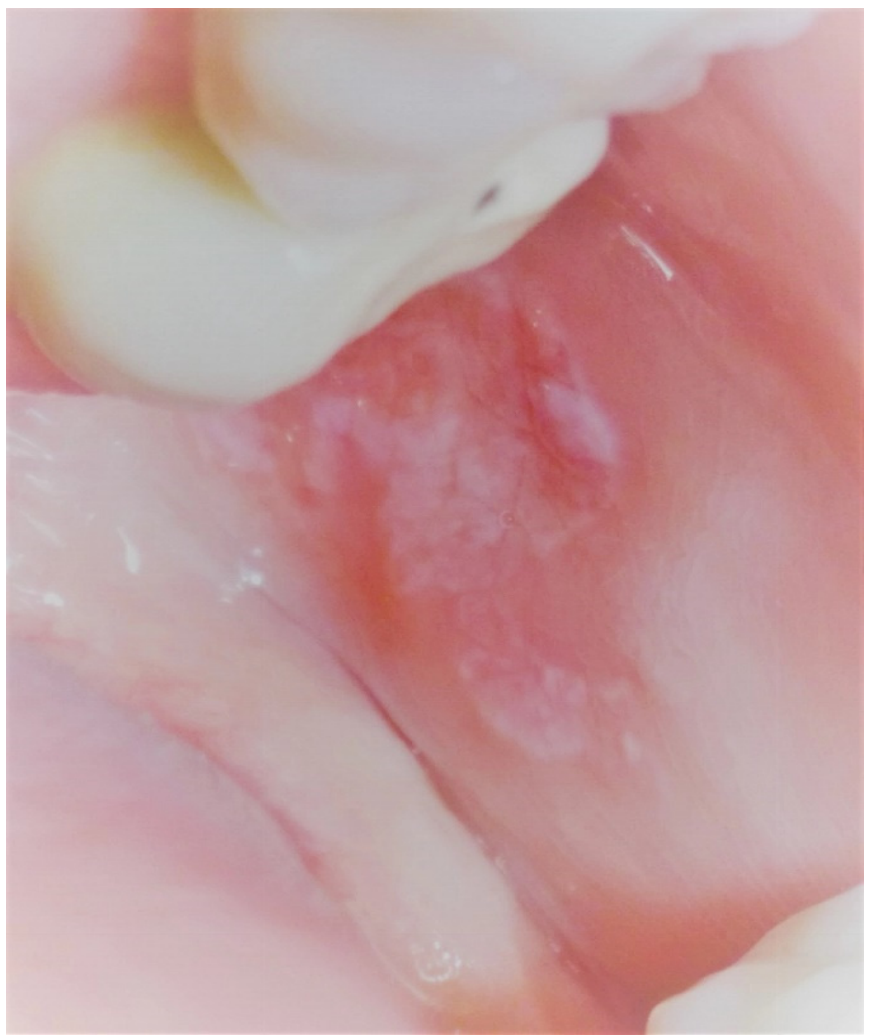
Figure 1. Clinical aspect of the erosive OLP on cheek.